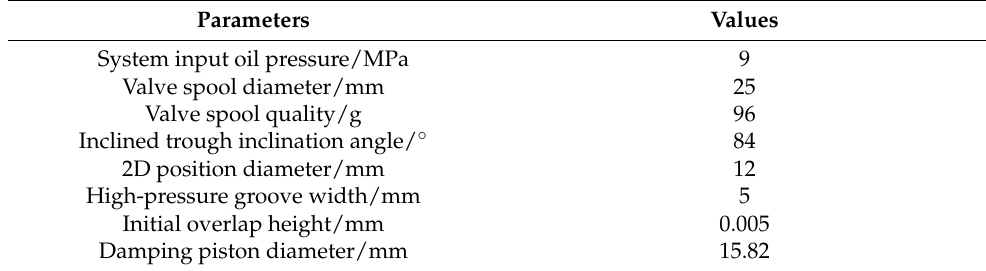
Table 3. Key parameters of the 2D electric feedback flow control valve.